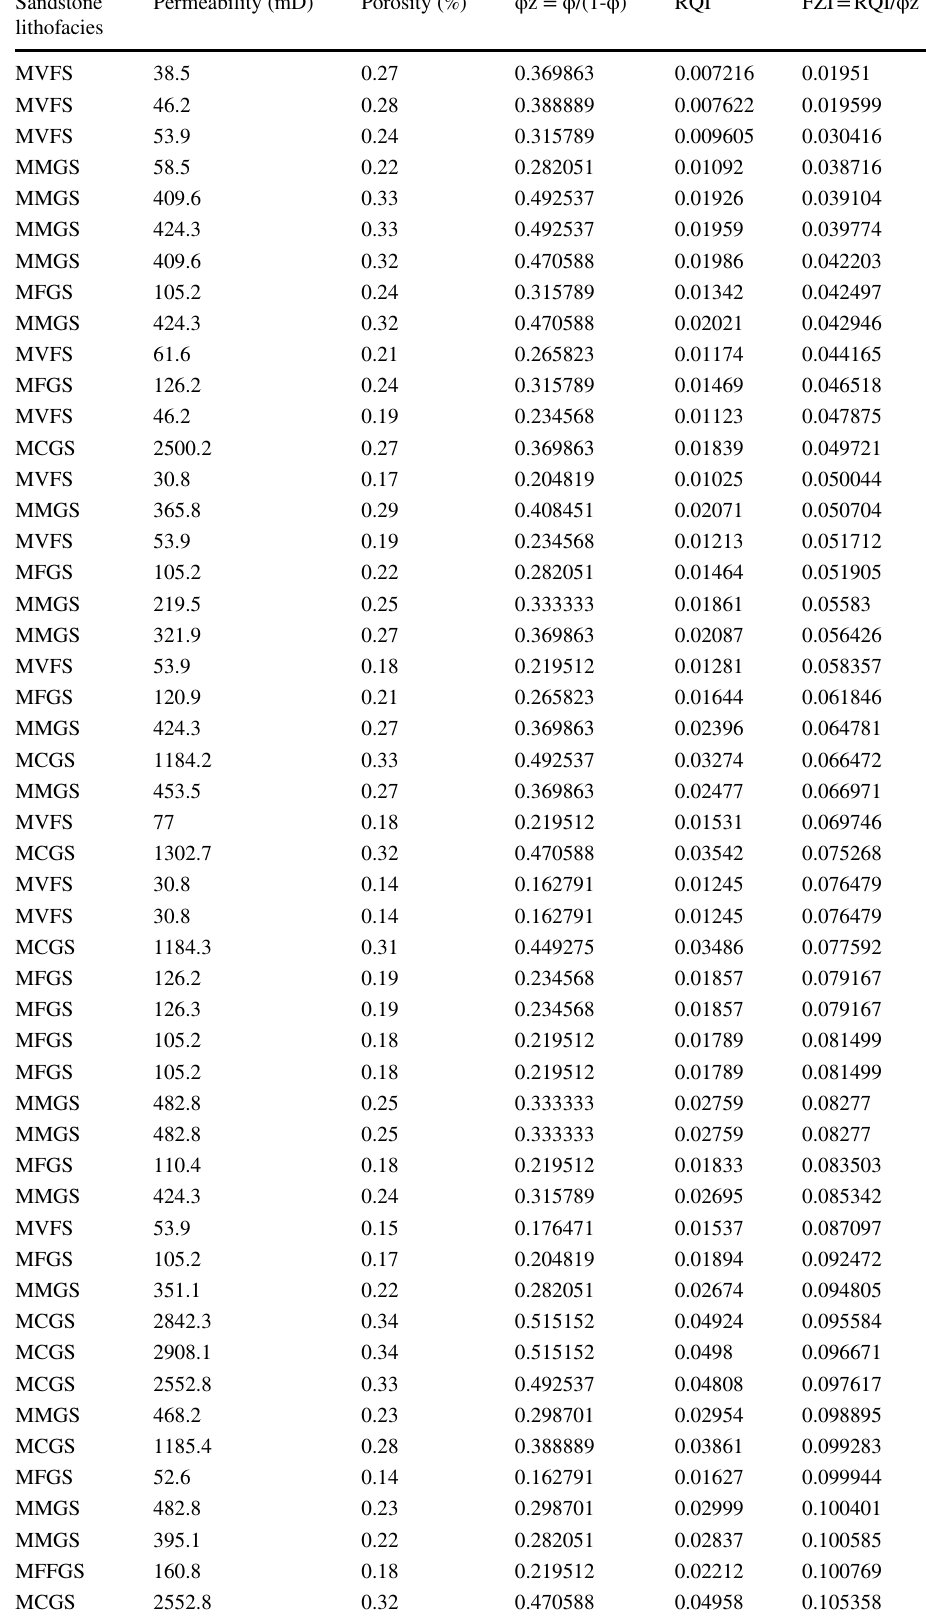
Table 1 Plotted values for RQI against ϕz for each of the